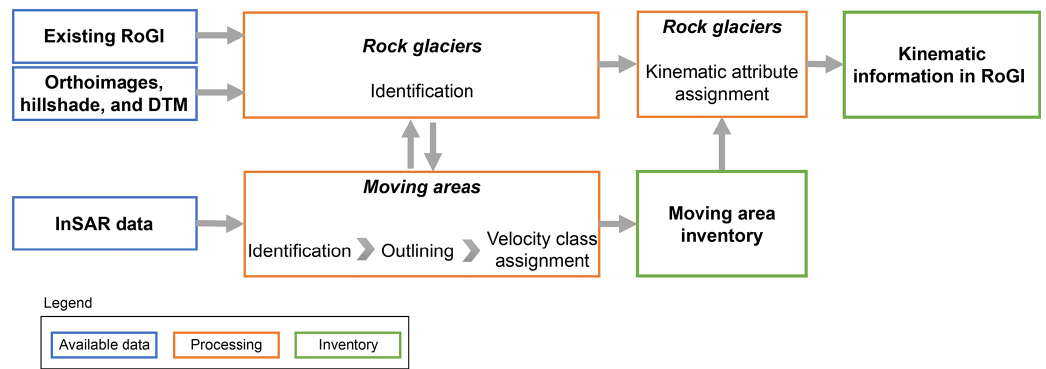
Figure 2. Conceptual diagram of the standardised method for producing a moving-area inventory and a RoGI that includes kinematic information. The analysis is performed in a GIS